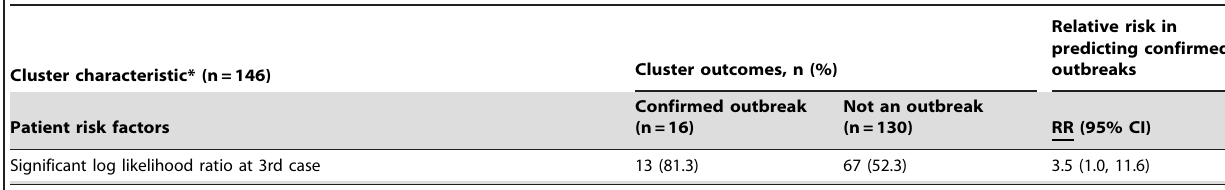
Cluster characteristic*